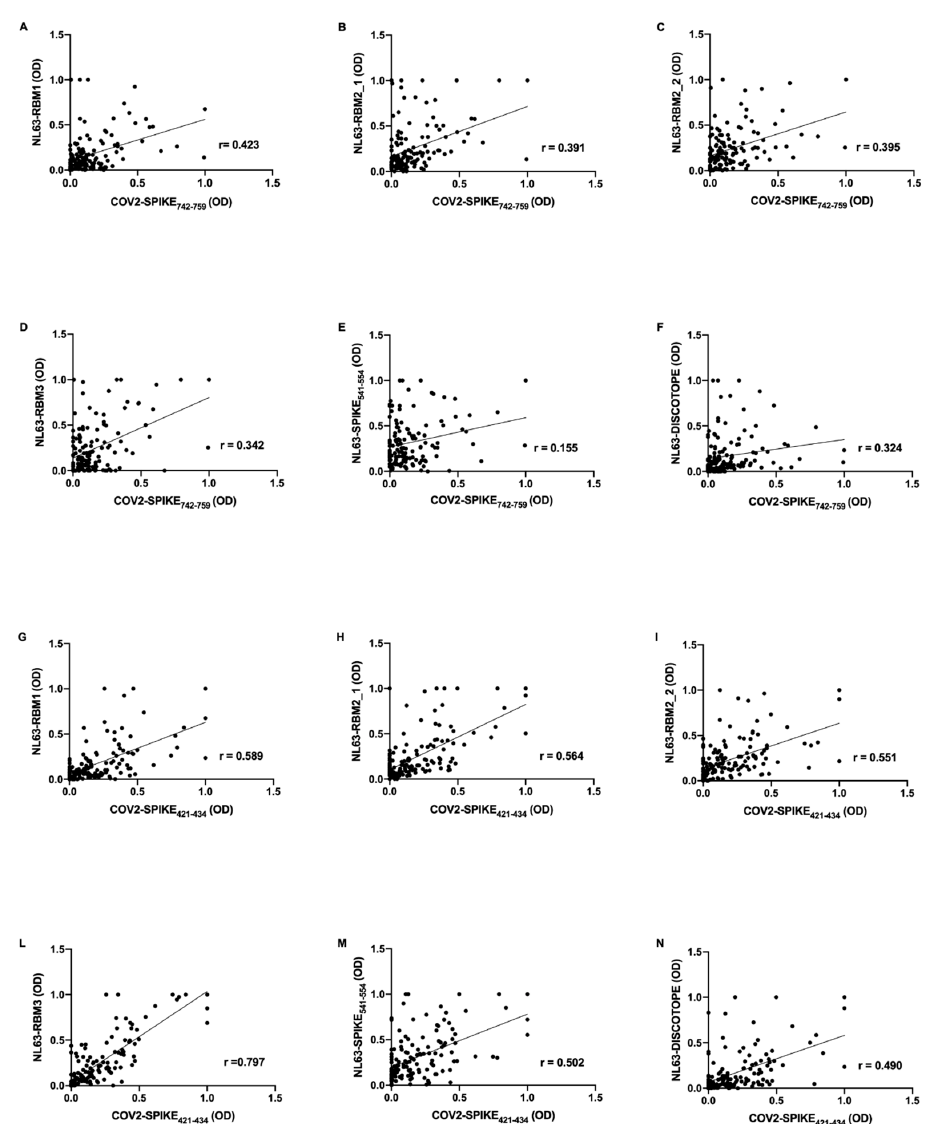
Figure 3. Scatter plot expressing correlation between SARS-CoV-2 and HCoV-NL63 derived peptides in mid-pandemic COVID19 cohort. The graphs show the correlation between COV2-SPIKE 742–759 and NL63-RBM1 ( A ), NL63-RBM2_1 ( B ), NL63-RBM2_2 ( C ), NL63-RBM3 ( D ), NL63-SPIKE 541–554 ( E ), NL63-DISC-like ( F ), and between COV2-SPIKE 421–434 and NL63-RBM1 ( G ), NL63-RBM2_1 ( H ), NL63-RBM2_2 ( I ), NL63-RBM3 ( L ), NL63-SPIKE 541–554 ( M ), NL63-DISC-like ( N ).